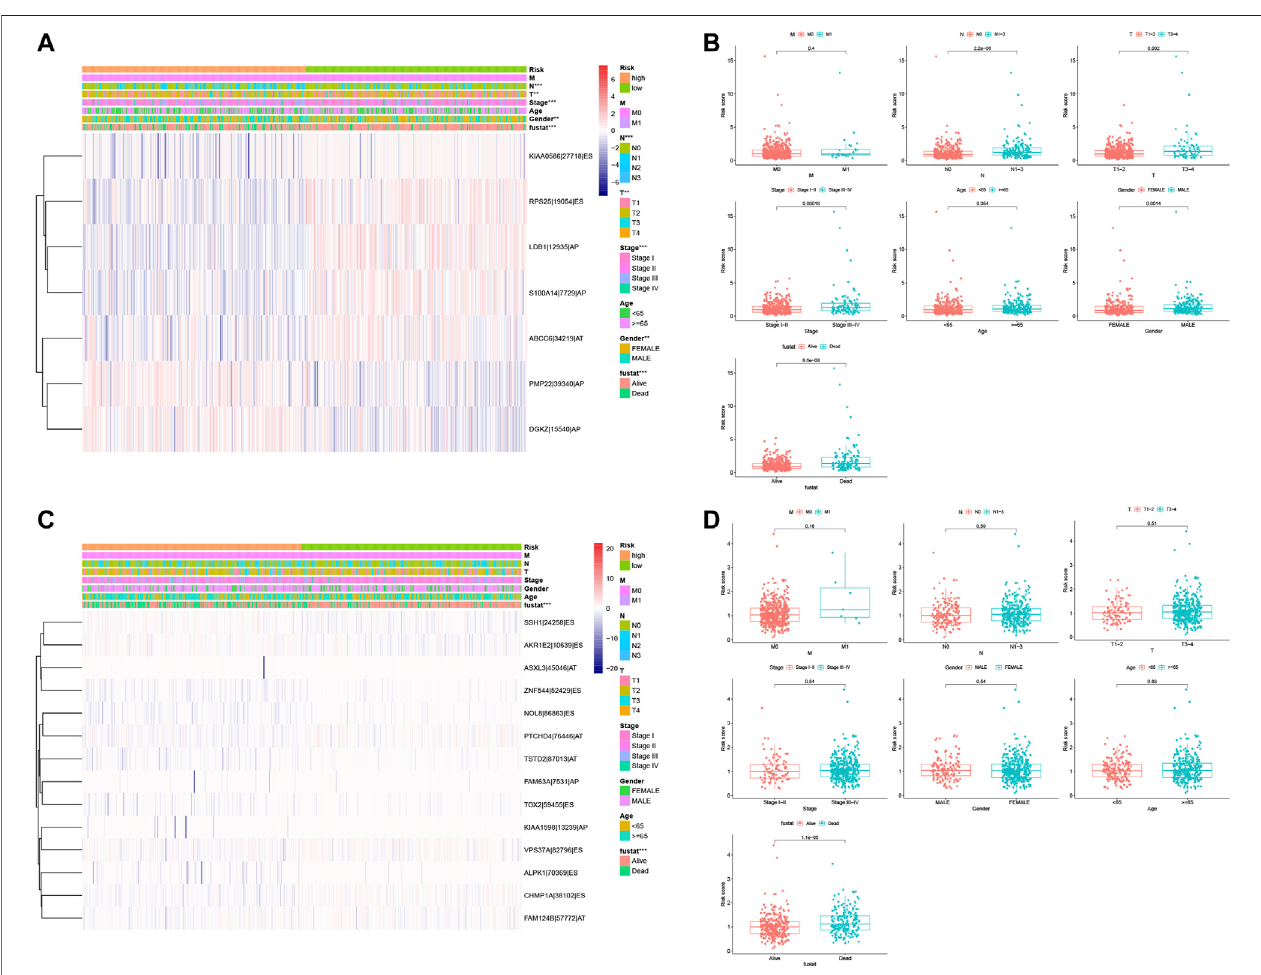
FIGURE 8 | Association of the risk signature with clinicopathological features from both LUAD and LUSC. (A) Heat map of different clinicopathological characteristicsfromhigh- vs. low-riskLUADsstrati fi edbypercent splicedindex(PSI)oftheASevents. (B) Associationoftheriskscoreswithclinicopathologicalfeatures from LUAD. (C) Heat map of different clinicopathological features of from high- vs. low-risk strati fi ed by the PSI of the AS events. (D) Association of the risk scores with clinicopathological features from LUSC. *** p < 0.001, ** p < 0.01, and * p < 0.05. AS, alternative splicing; LUAD, lung adenocarcinoma; LUSC, lung squamous cell carcinoma; PSI, percent spliced in